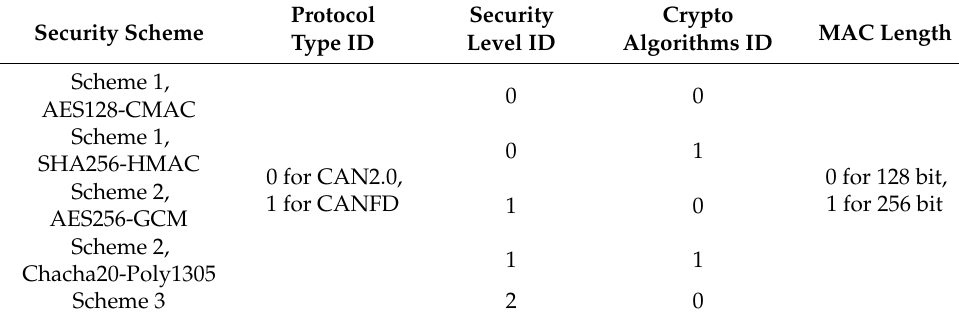
Table 3. Values of sub-header